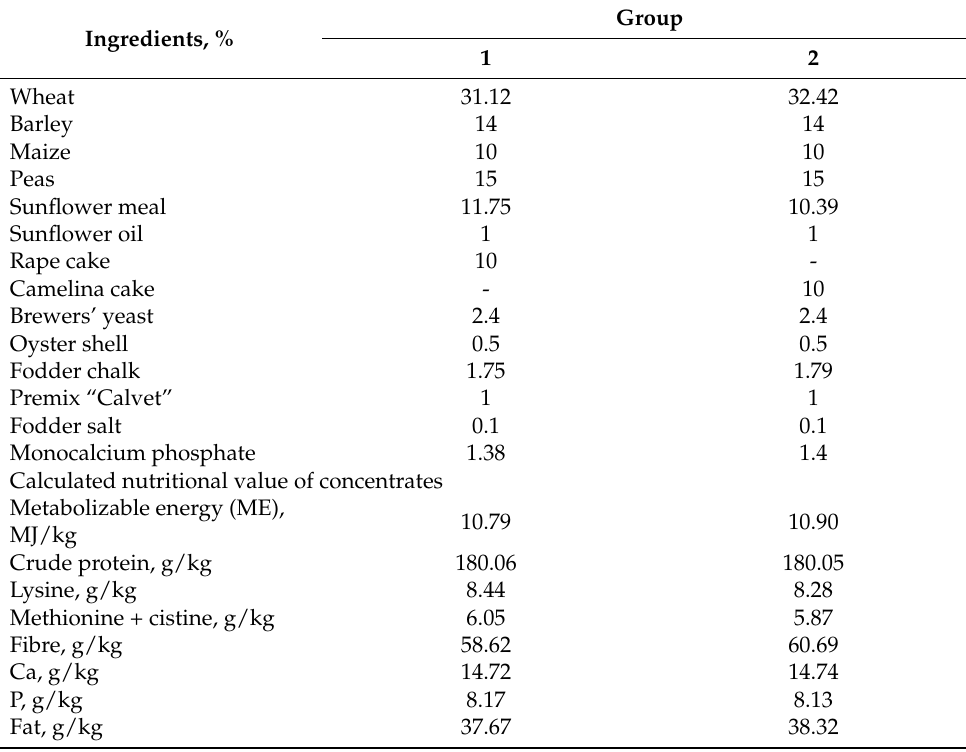
Table 1. Composition of goose feed and its nutritive